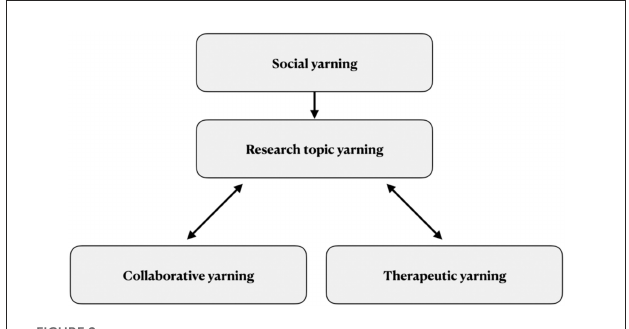
FIGURE2 The yarning research process (36). This flowchart created by Ng’andu and Bessarab outlines the four different types of yarns that are involved in research through yarning (36). Firstly, there is social yarning: an unstructured conversation that takes place before the research occurs to build trust and accountability by identifying yourself and your experiences. Subsequently, there is research topic yarning to collect information pertaining to the research question through the participants’ stories. The research topic yarn can transition to collaborative yarning, in which information about the research project and ideas are shared, and to therapeutic yarning, which takes place when a participant discloses traumatic or sensitive information. The researcher transitions to the role of a listener, to help affirm and facilitate the participant’s meaning-making in voicing their